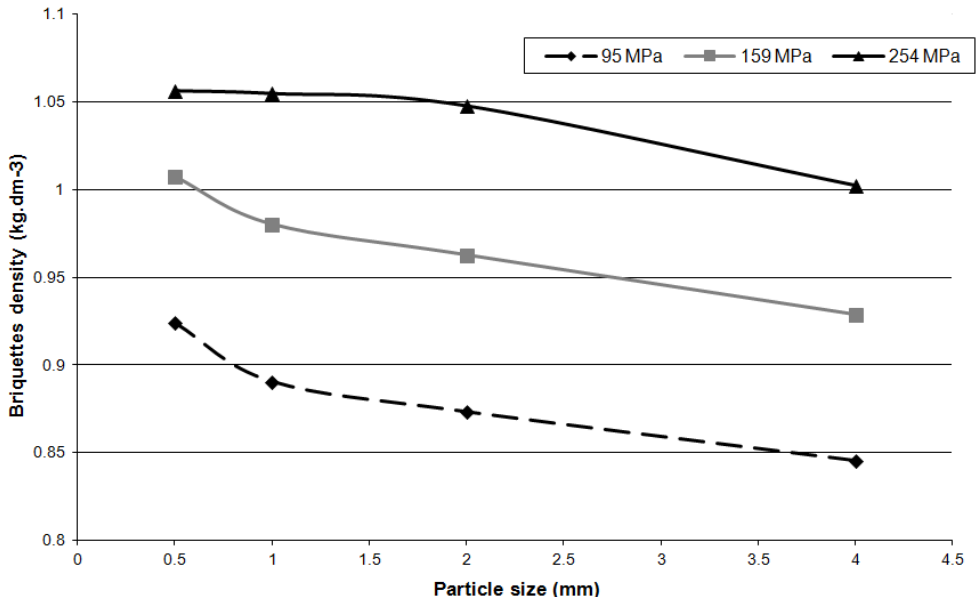
Figure 10. Dependence of briquette density on particle size ( w r = 8%; T = 25 °C).